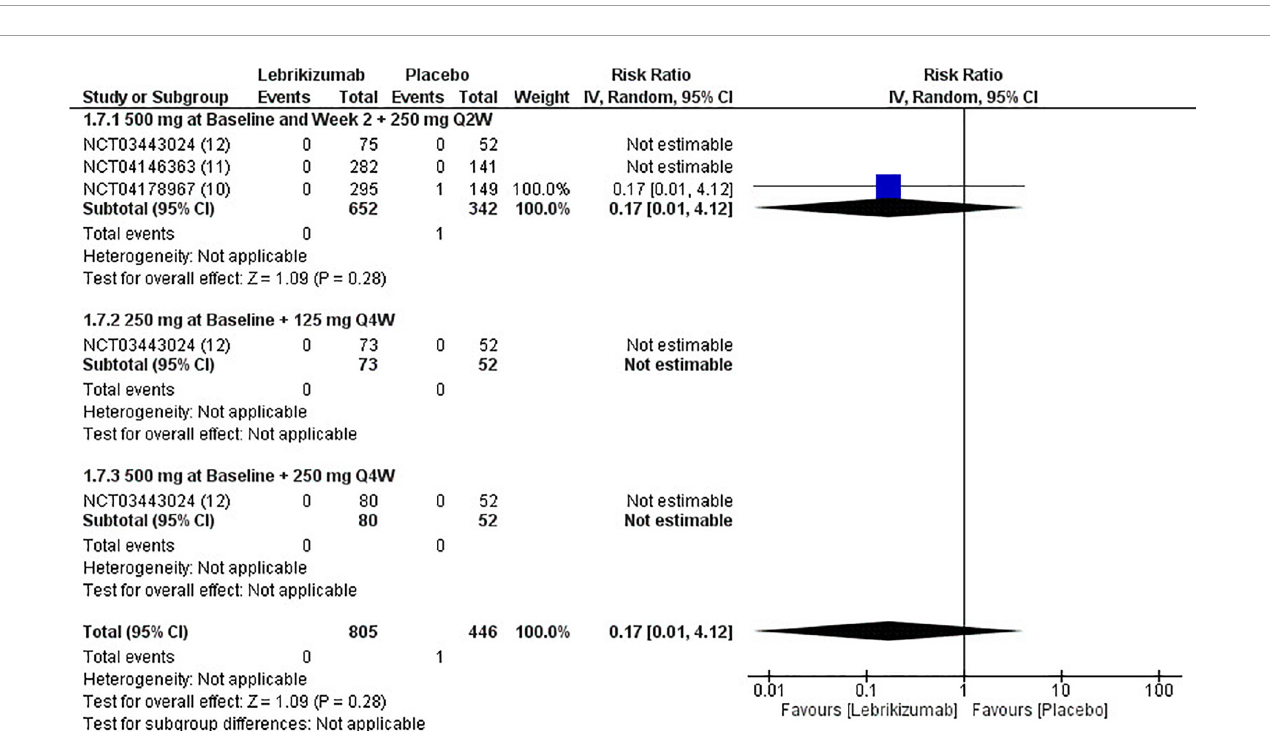
FIGURE11 Forest plot of mortality. CI, confidence interval; IV, inverse variance; RR, risk ratio; Q2W, every 2 weeks; Q4W, every 4